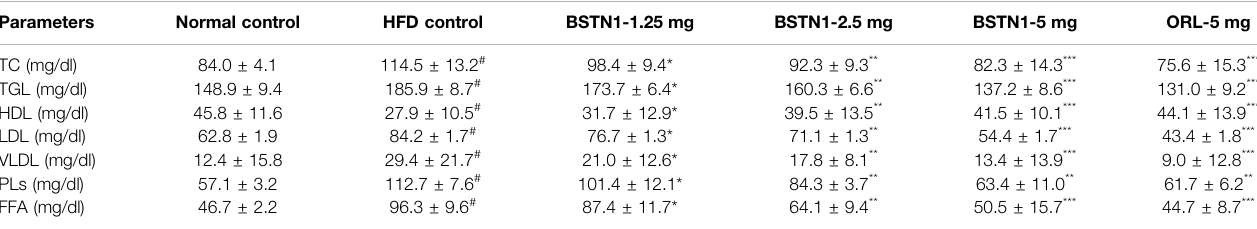
TABLE 2 | Effect of BSTN1 on serum lipid pro fi le of treated and untreated rats.